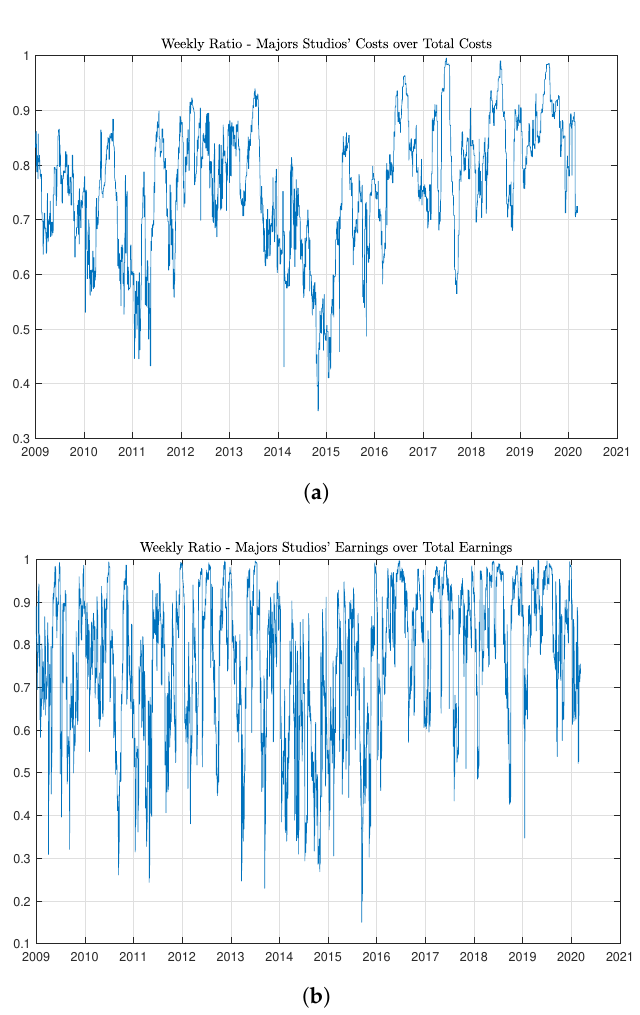
Figure 17. Panel ( a ): ratios between daily production costs related to movies produced or distributed by major public companies over the total value of daily production costs c t . Panel ( b ): ratios between daily box office earnings related to movies produced or distributed by major public companies over the total value of daily box office earnings y t